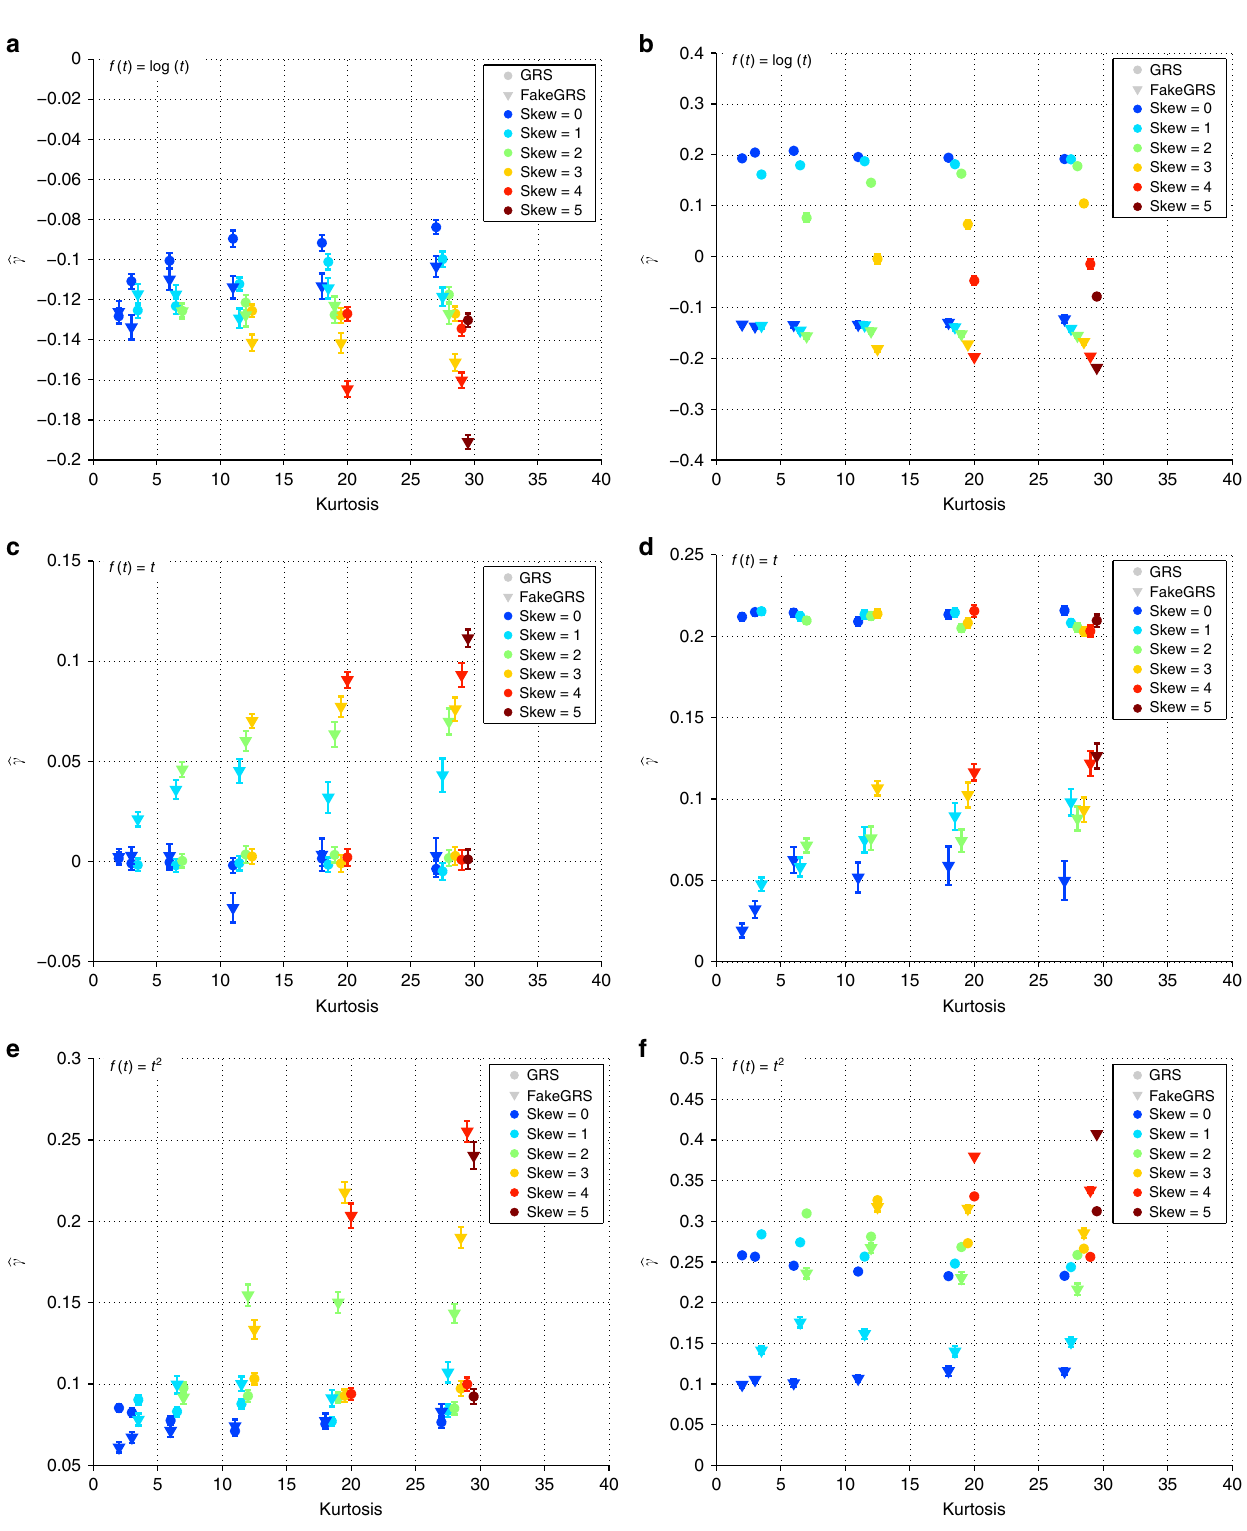
Fig. 3 Error bars for the interaction effect estimates ( b γ ). Error bars show mean ± SE and are based on 100 simulated data sets. Estimates for the real data are marked with bullets and for fake G with triangles. Rows 1 – 3: Transformation power ( p = 0, 1, 2: f ( t ) = t p ). Left column: without GxE interaction ( γ = 0), ffiffiffiffiffiffiffiffiffiffi p right column: with GxE interaction ( γ ¼ 0 : 05 (cid:4) 0 : 22). Other parameters were fi xed at n = 10,000, α 2 1 ¼ 0 : 05, α 2 = 0 and β 2 = 0.3. The indicated skewness and kurtosis values refer to the error term ϵ